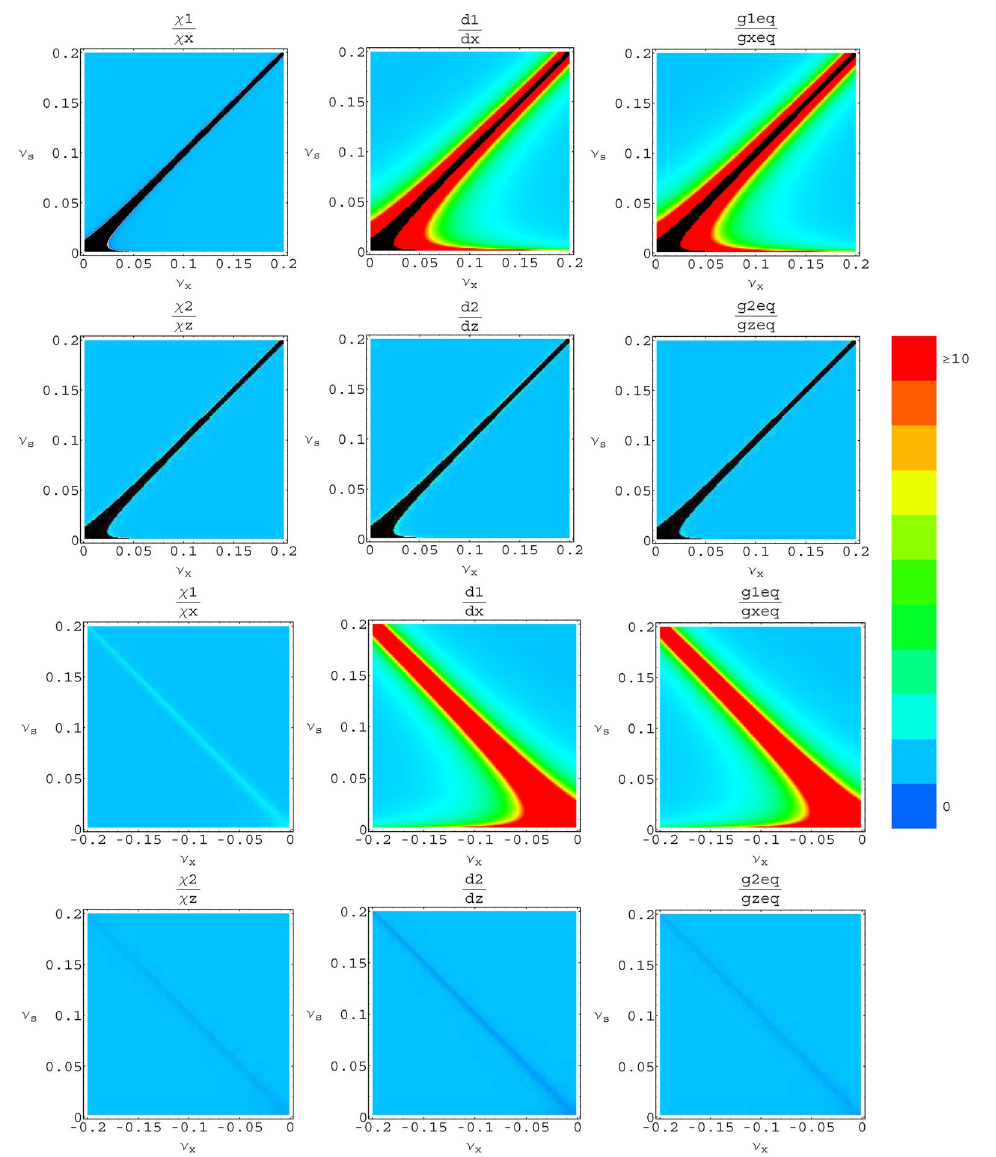
FIG. 2. (Color) In this figure, we plot global damping, diffusion, and equilibrium invariant values for coupling due to a crab cavity with (cid:4) 0 : 003 near the sum and difference resonances. The dispersion at the crab cavity is set to 0 in this example. Because the coupling (cid:4) c strength (cid:4) is inversely proportional to (cid:5)(cid:5)(cid:5)(cid:5)(cid:5) (cid:7) As in Fig. 1, the small region of antidamping for (cid:3)